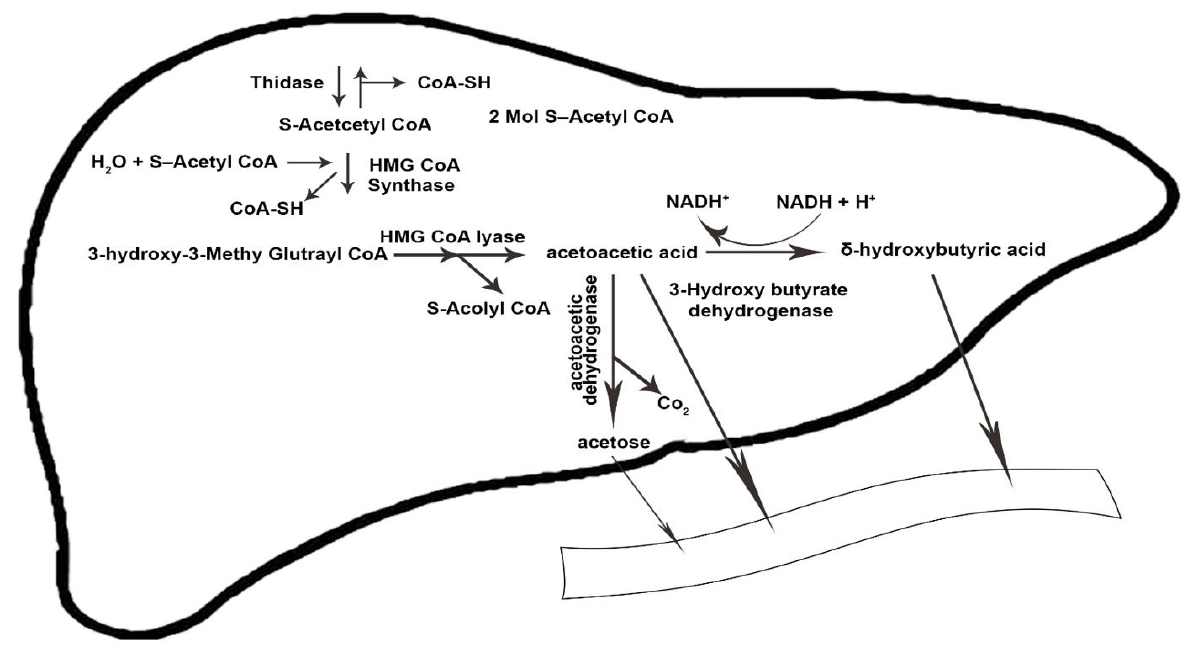
Figure 1. The ketogenesis process in the body. CoA-SH, coenzyme A-SH; CoA, coenzyme A; H 2 O, water; HMG-CoA, 3-hydroxy-3-methylglutaryl coenzyme A; NADH + , nicotinamide adenine dinucleotide + hydrogen; H + , Hydrogen; Co 2 , carbon dioxide. The arrows indicate the direction of changes in the process, as well substrates and